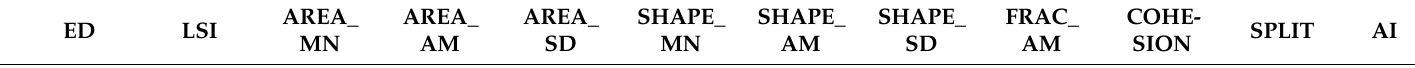
Table A3. The Spearman analysis results of landscape